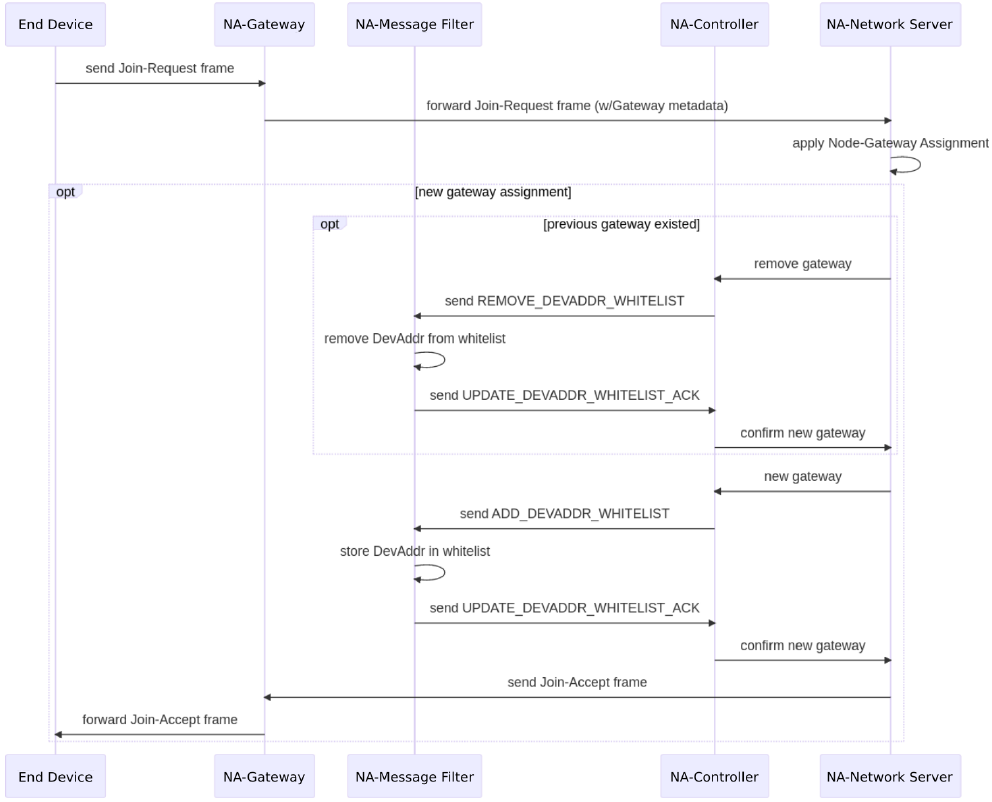
Figure 4. Gateway whitelist updating sequence.